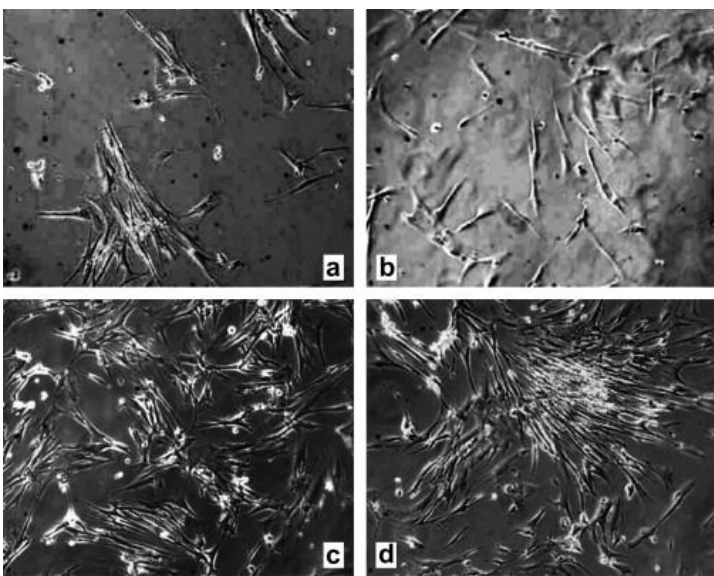
Figure 1. Representative images (10 × ) of MRC-5 cells after 3 days of cultivation on ( a ) plasma activated soda-lime glass, ( b ) an untreated SU-8 surface, ( c ) an oxygen plasma activated SU-8 with a dose of 2.77 J/cm 2 and ( d ) 22.2 J/cm 2 . Reprinted from Hennemeyer et al. [27] with permission from Elsevier.